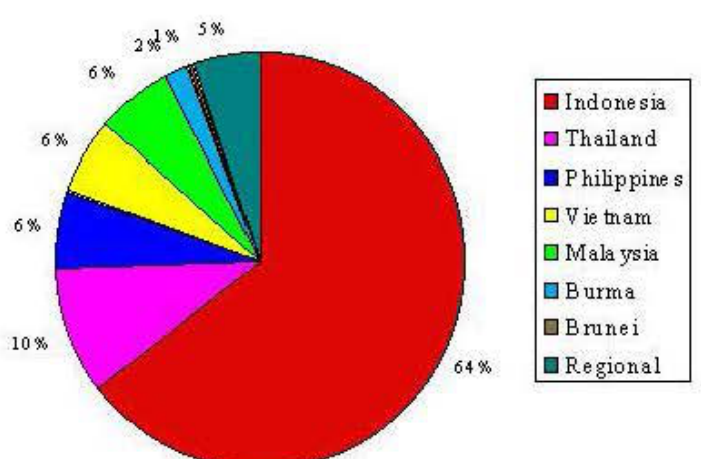
Figure 6 . .laakko Pi\}'TY Group's Sontheast Asian projects. 1971·92. by country. n=l69. Figure 7. Jtul.l<ko Poy1y gl'oup stl'uctu,·e, c. 1993